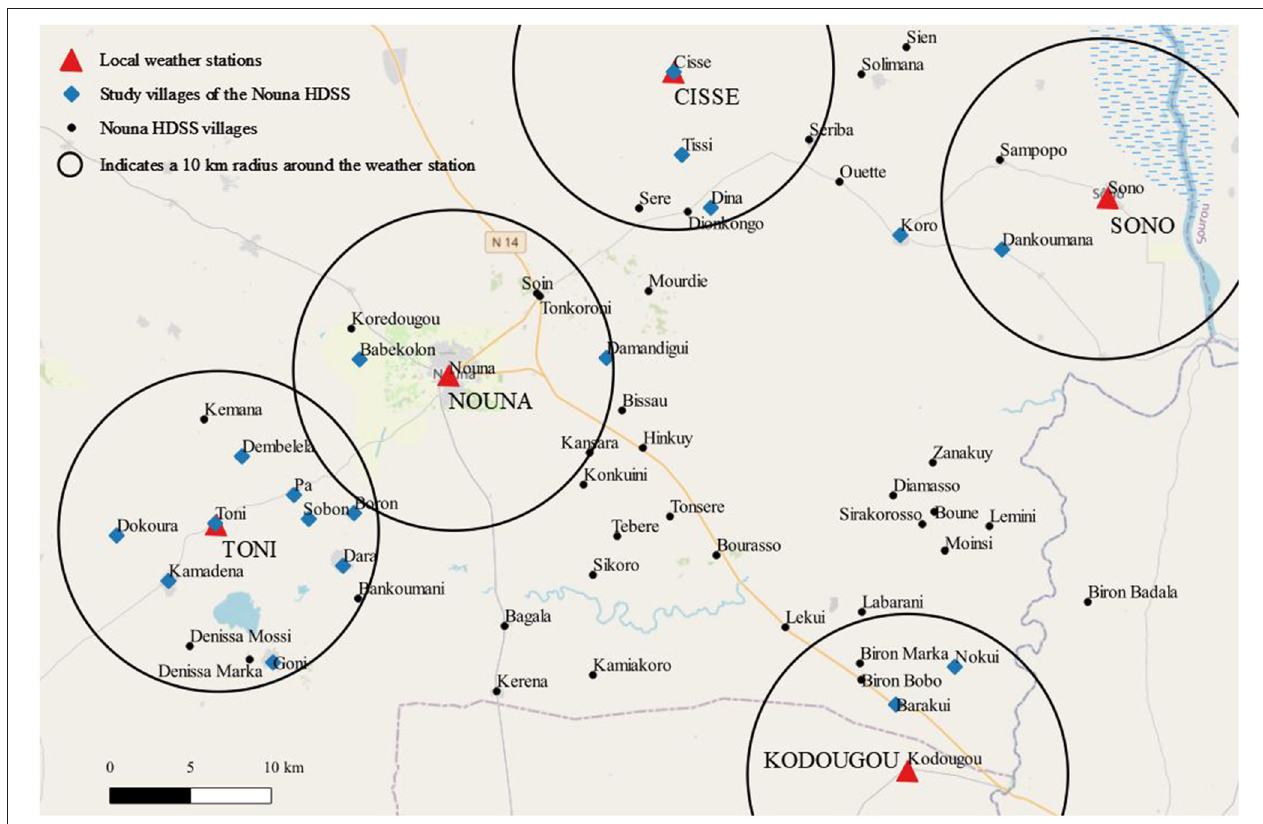
FIGURE 1 | Study area with five strata in the Nouna HDSS area. One village (Koro) was added in order to assure the representativeness of the less densely populated stratum although it lies a few kilometers outside of the sampling frame. The circles indicate the 10 km radius around the respective weather